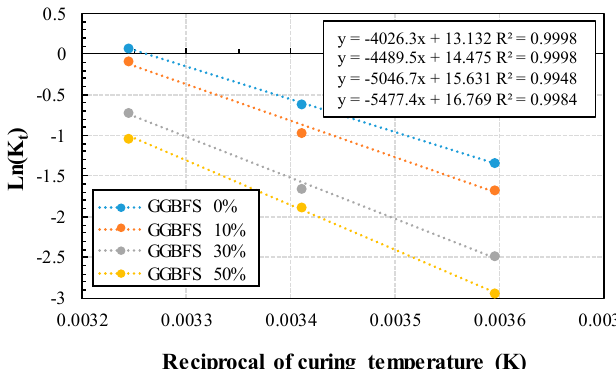
Figure 6. Arrhenius plot of ASTM C 1074 for calculating E a.